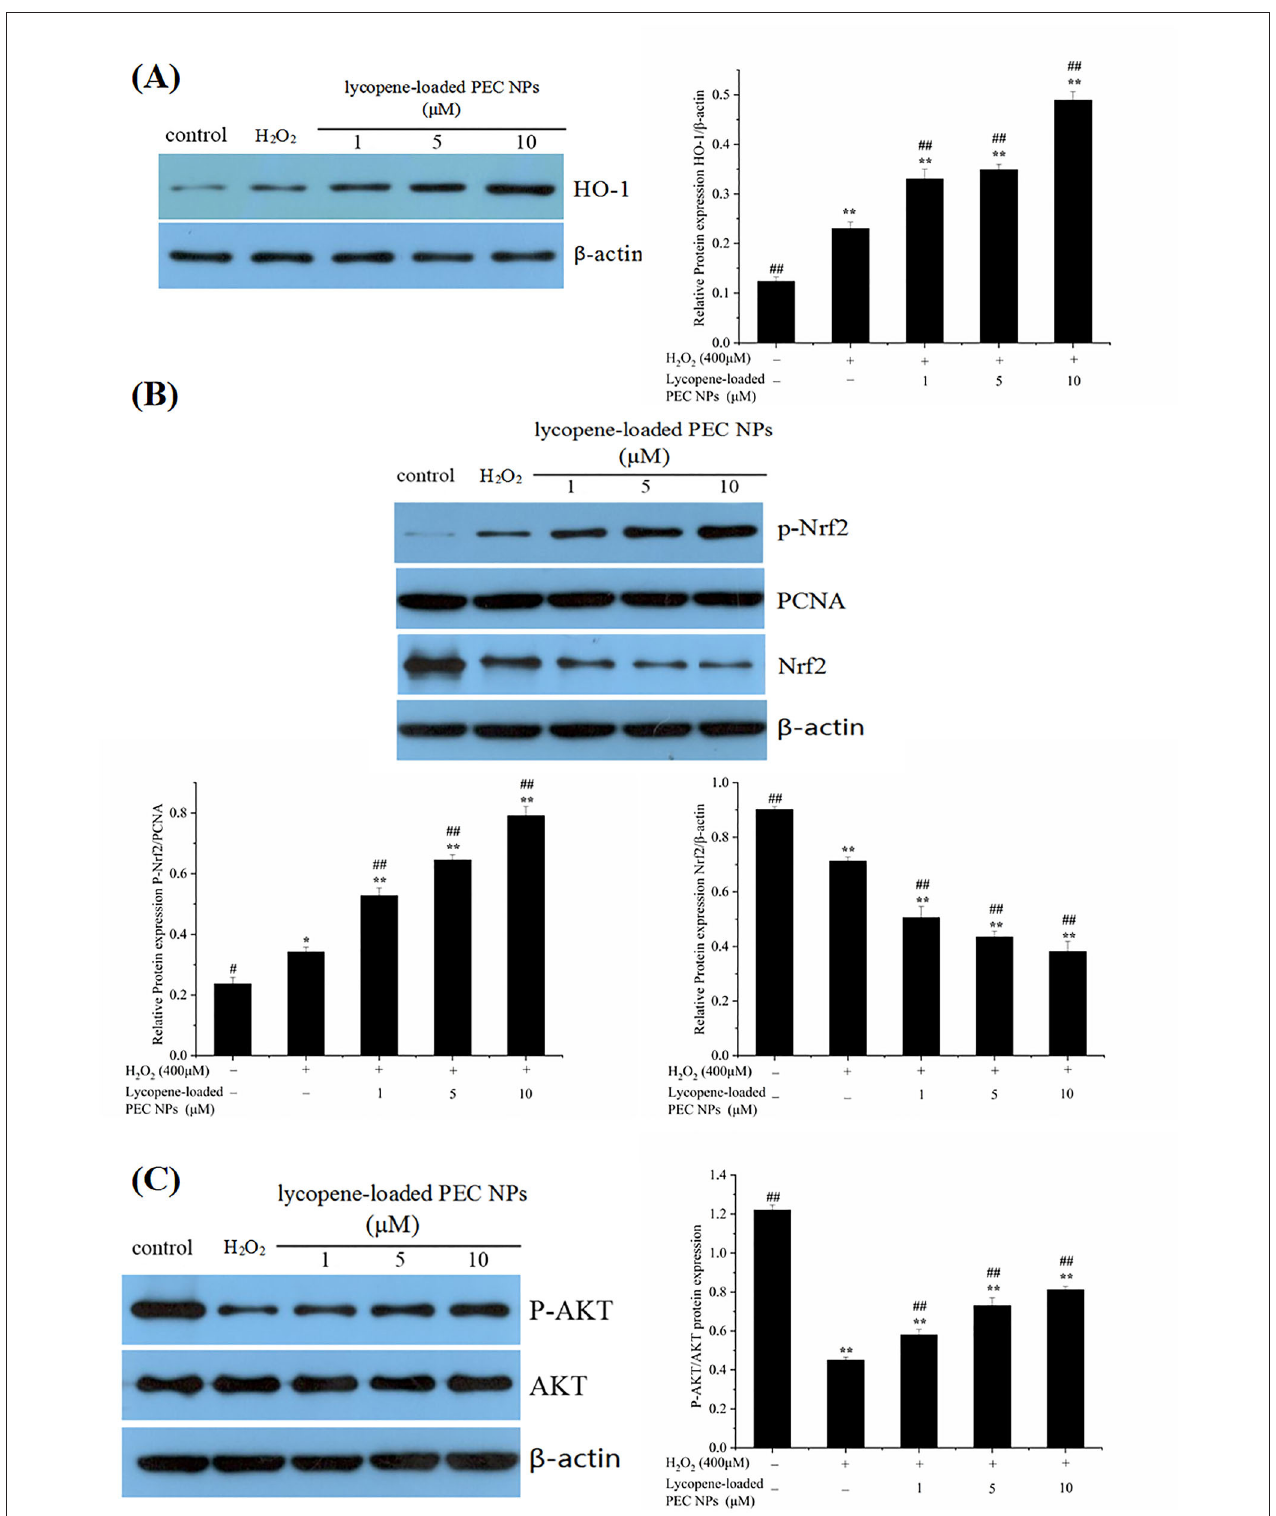
FIGURE 13 | Mechanism of protective effects on H 2 O 2 -treated L02 cells. (A) Western blot assay of HO-1 expression; Quantification of relative protein expression quantity of HO-1 . (B) Western blot assay of p-Nrf2 and Nrf2 expression. Quantification of relative protein expression quantity of p-Nrf2 and Nrf2. PCNA was used as a nuclear loading control. (C) Western blot assay of p-AKT and AKT; Quantification of relative protein expression quantity of p-AKT/AKT. Data (mean ± SD) represent three experimental replicates. * p < 0.05, ** p < 0.01, vs. control group. # p < 0.05, ## p < 0.01, vs. H 2 O 2 -treated group.